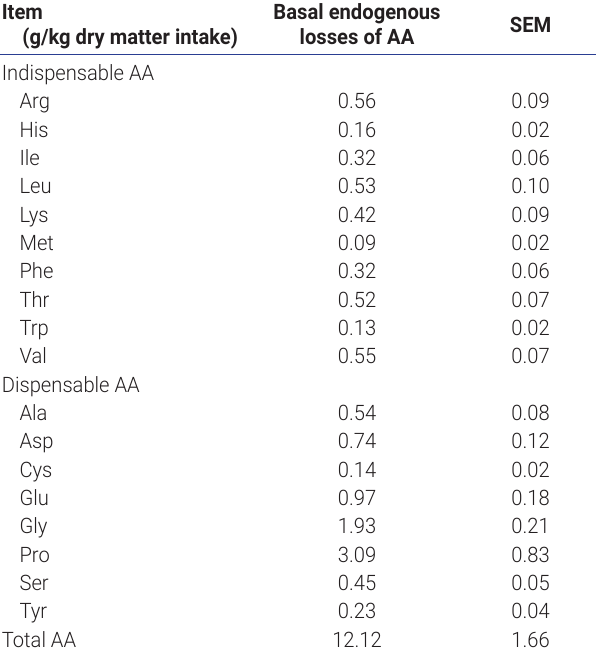
Table 7. Apparent ileal digestibility of amino acids in fermented soy- bean meal calculated using direct and difference procedures Item